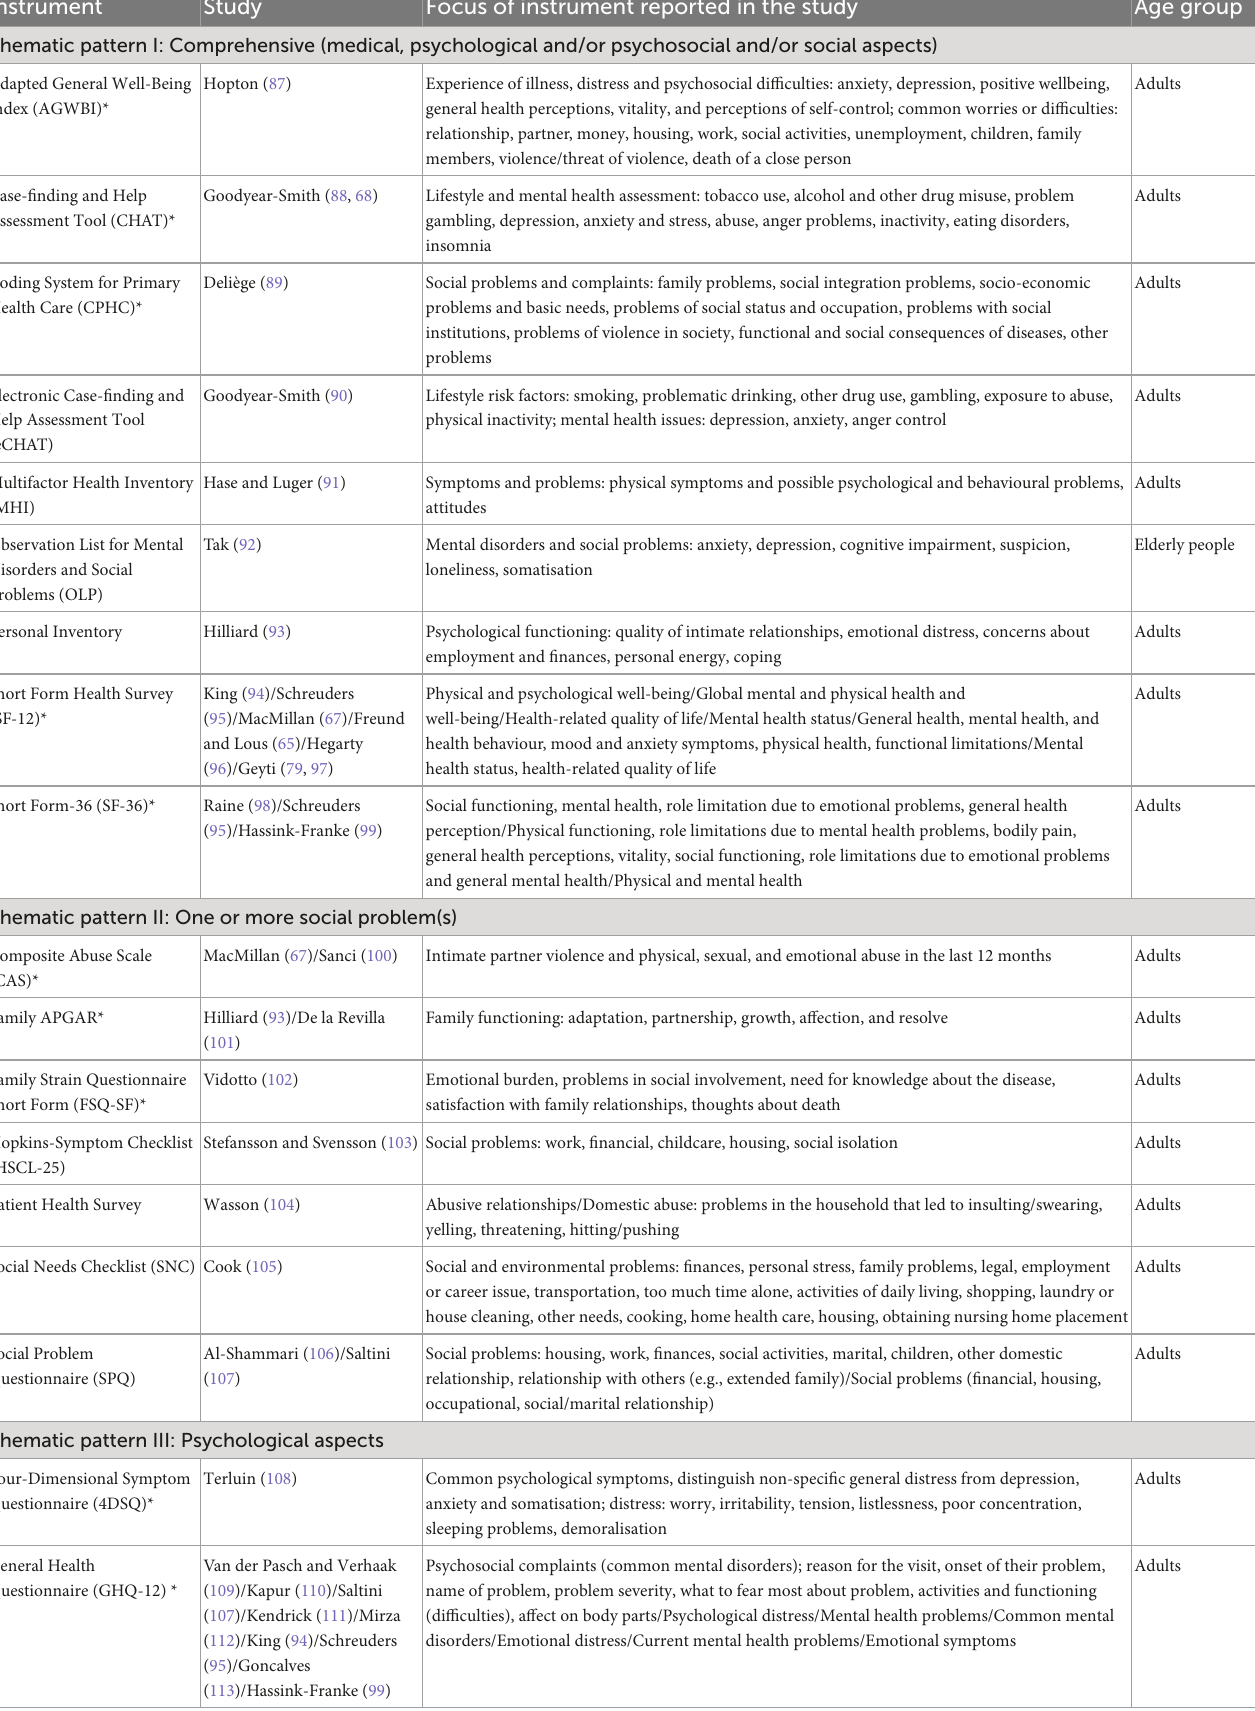
TABLE 2 Instrument characteristics.